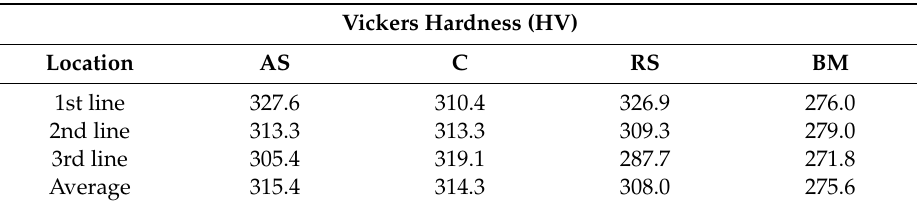
Table 4. Hardness of BM and FSPed 2507 SDSS.